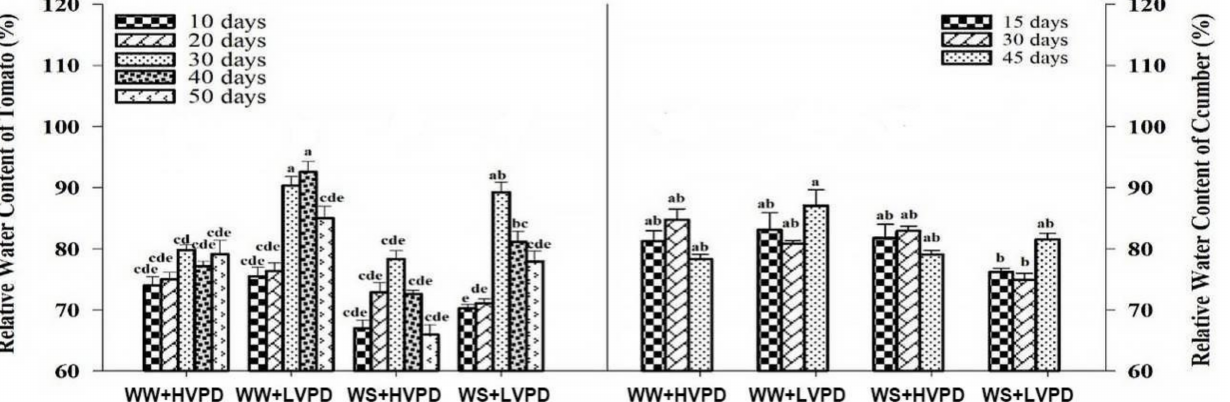
Figure 2. Effects of VPD and soil moisture on the RWC of tomato and cucumber plants. Data represent means ± standard error ( n = 10). Letters represent significant differences between treatments. Different letters indicate significant differences ( p < 0.05). WW (well-watered, 100%FC) + HVPD (high vapor pressure deficit); WW (well-watered, 100%FC) + LVPD (low vapor pressure deficit); WS (water stress, 60%FC) + HVPD (high vapor pressure deficit); WS (water stress, 60%FC) + LVPD (low vapor pressure